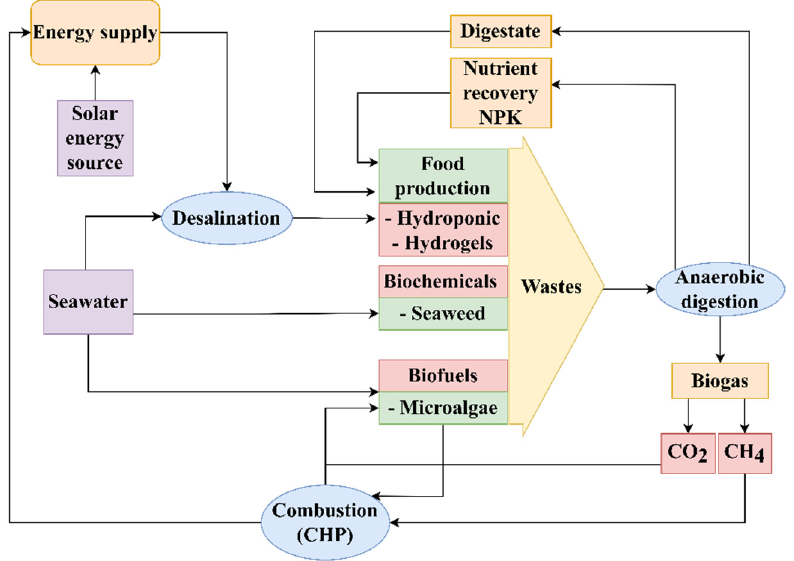
Figure 1. Schematic of a suggested circular economy to develop in coastal arid regions.